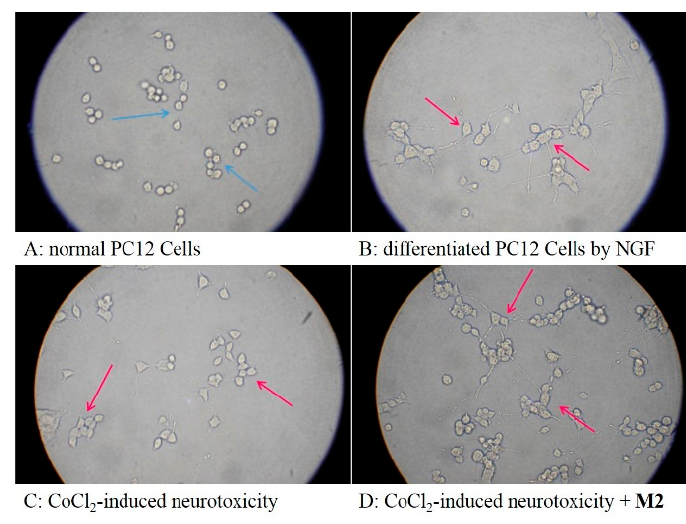
Figure 6. Effects of M2 on differentiated PC12 cell injury in morphology ( × 200); ( A ) undifferentiated PC12 cell; ( B ) PC12 cell differentiated by NGF; ( C ) CoCl 2 -induced differentiated PC12 cell; ( D ) CoCl 2 -induced neurotoxicity with M2 (60 μ M). Table 2. Neuroprotective activity of metabolites M1, M2, and M4.